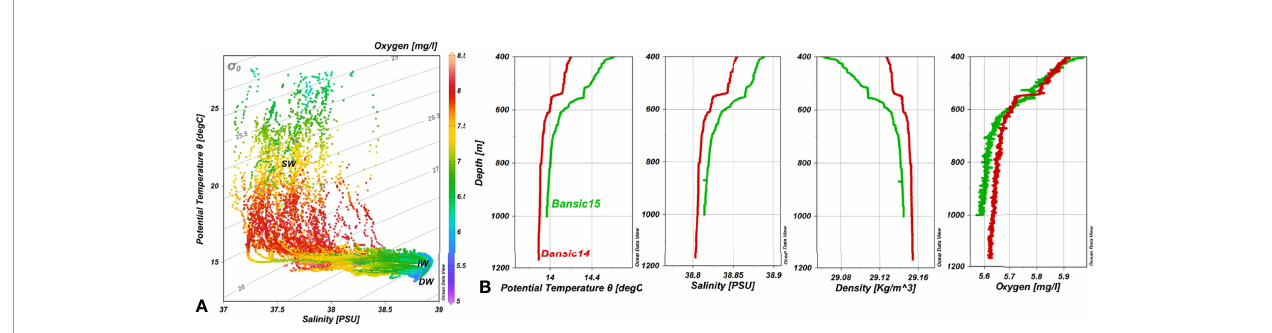
FIGURE 2 | (A) q -S diagram and DO of all monitored stations. (B) zoom of the DW and related q , S, s and DO vertical pro fi les at the station 623 detected during Bansic 2014 (red line) and 2015 (green